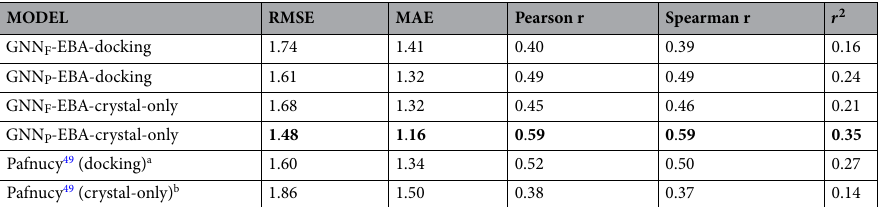
Table 7. Performance comparison of our GNN models in predicting experimental affinity on the PDBbind dataset. The top scores are shown in bold. a 255 test targets from our PDBbind2018-EBA-docking dataset using all docked poses for evaluation; b PDBBind2018-EBA-crystal-only test